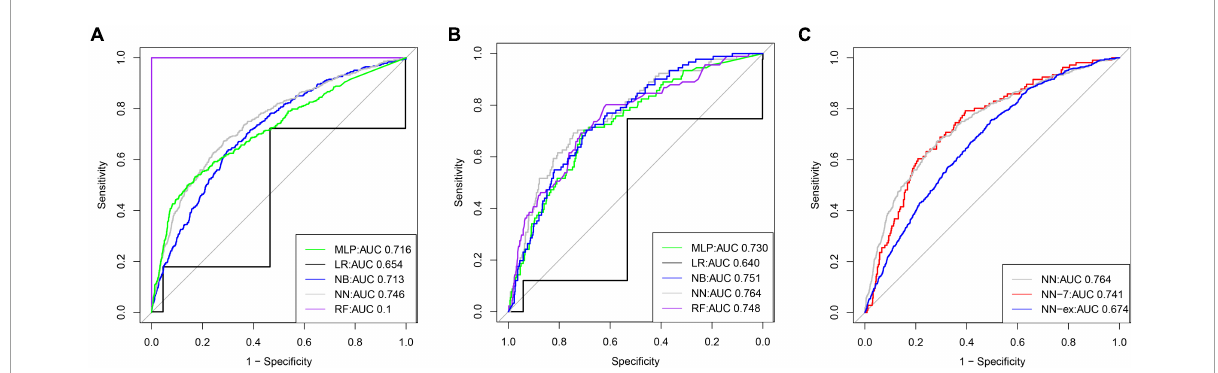
FIGURE4 The receiver operator characteristic (ROC) curves for the ML models predict in-hospital mortality (The training cohort and testing cohort). ROC curves for five ML models predicting in-hospital mortality in the training (A) and testing cohort (B) , respectively; (C) ROC curves for in-hospital mortality in the test set predicted by the un-simplified NN model and the ROC curves for in-hospital mortality in the test set and external validation set predicted by the simplified NN model, respectively.